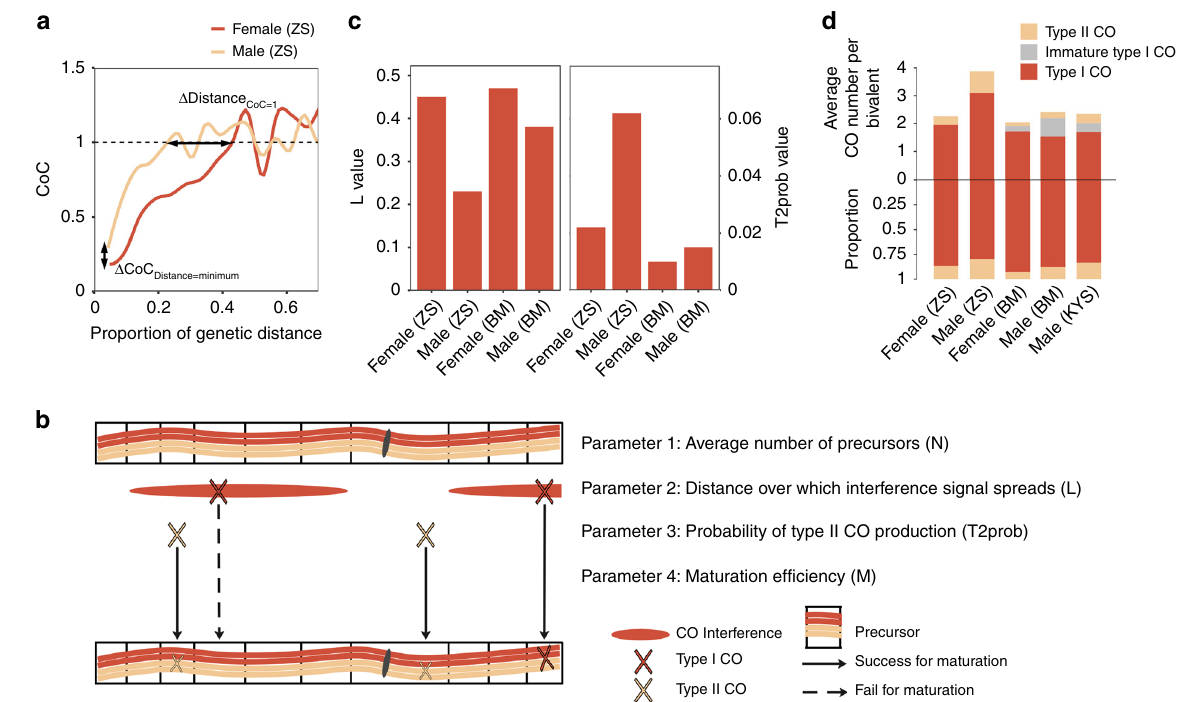
Fig. 3 Features of crossover (CO) interference exhibiting sex difference. a The CoC curves for female and male gametophyte populations. Distance CoC = 1 represents the distance at which CoC = 1. CoC Distance = minimum represents the CoC value at minimum distance. Δ Distance CoC = 1 and Δ CoC distance = minimum represent the D -value of Distance CoC = 1 and CoC distance = minimum between sexes, respectively. b A diagram illustrating the Beam-Film model shows the main steps of CO formation and the main parameters for these steps. c The values of parameters L and T2prob in male and female meiosis within different genetic backgrounds. d The numbers (upper) and proportion (lower) of type I and II COs were shown. The putative numbers of immature type I COs derived from CMI were also present (gray in upper half of the graph). ZS is short for the F 1 from the cross of inbred lines Zheng58 and SK, pro fi led by single gametophyte sequencing. BM is short for the F 1 from the cross of inbred lines B73 and Mo17, pro fi led by sequencing progeny from reciprocal crosses. Source data of Fig. 3a are provided in a Source Data fi Figure 11). For long chromosomes (chr. 1 – 5, 135.71 – 108.19 μ m for KYS male SC) and short chromosomes (chr. 6 – 10, 93.83 – 77.7 μ m), L values were higher in female (0.30 and 0.46) than in